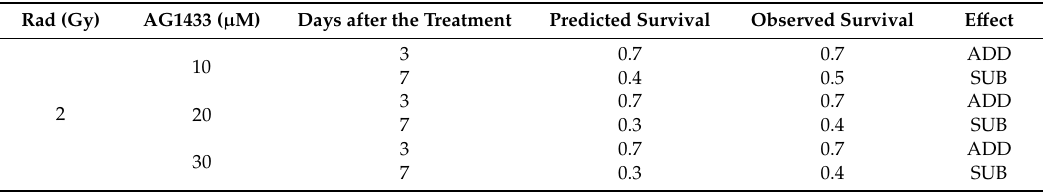
Table 1. Observed e ff ects for the 11 HGG cell